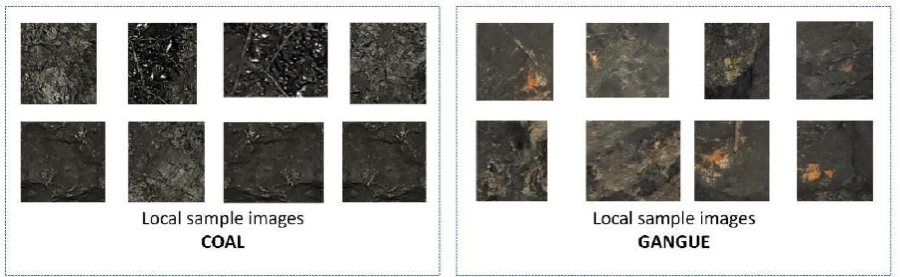
Figure 3. Local texture images are more distinct and separable compared to full-scale images Method.